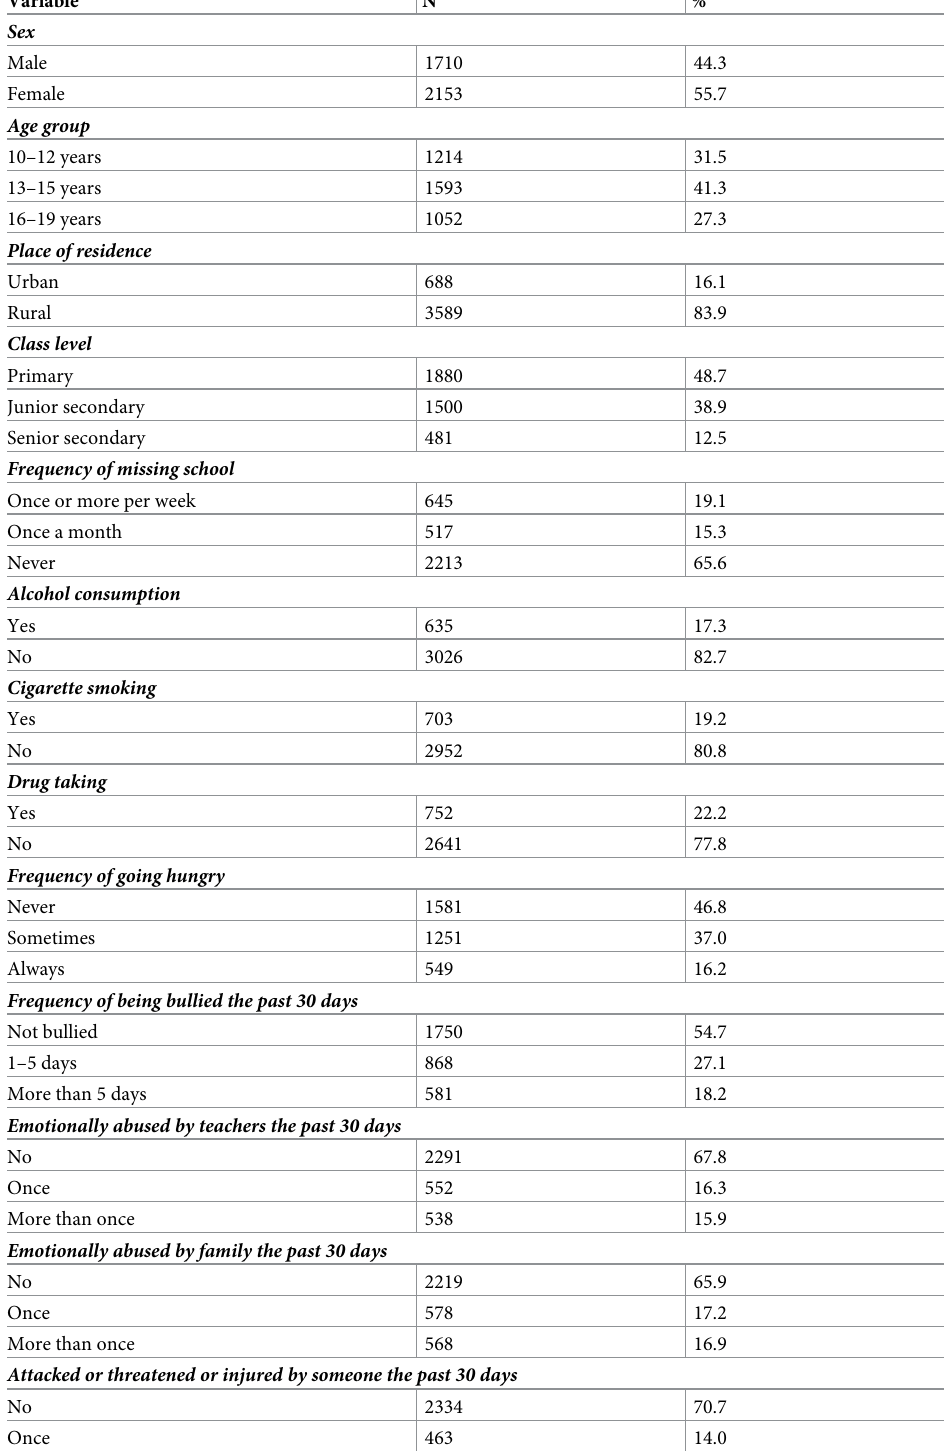
Table 1. Sample characteristics of primary and secondary schools’ learners in Botswana aged 10–19 years at the time of the survey, BYRBBSS (N =